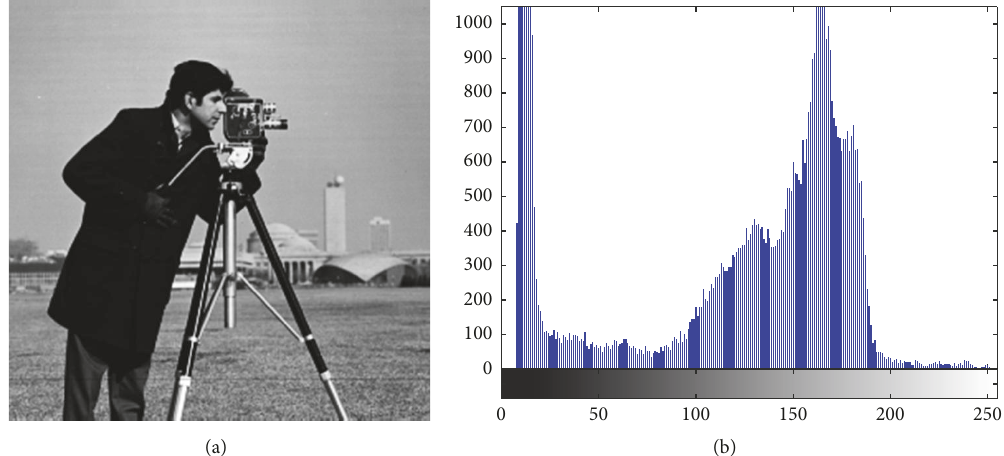
Figure 12: Typical image “cameraman”: (a) original image and (b) corresponding